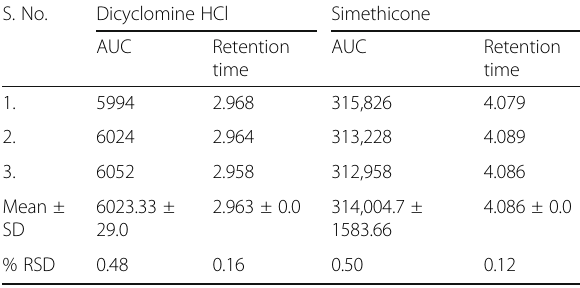
Table 6 Repeatability study of intra-day samples for developed analytical method